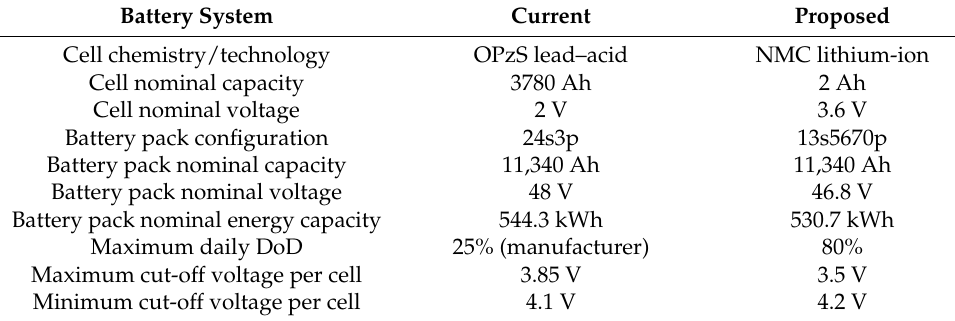
Table 10. Current and proposed battery system specifications.